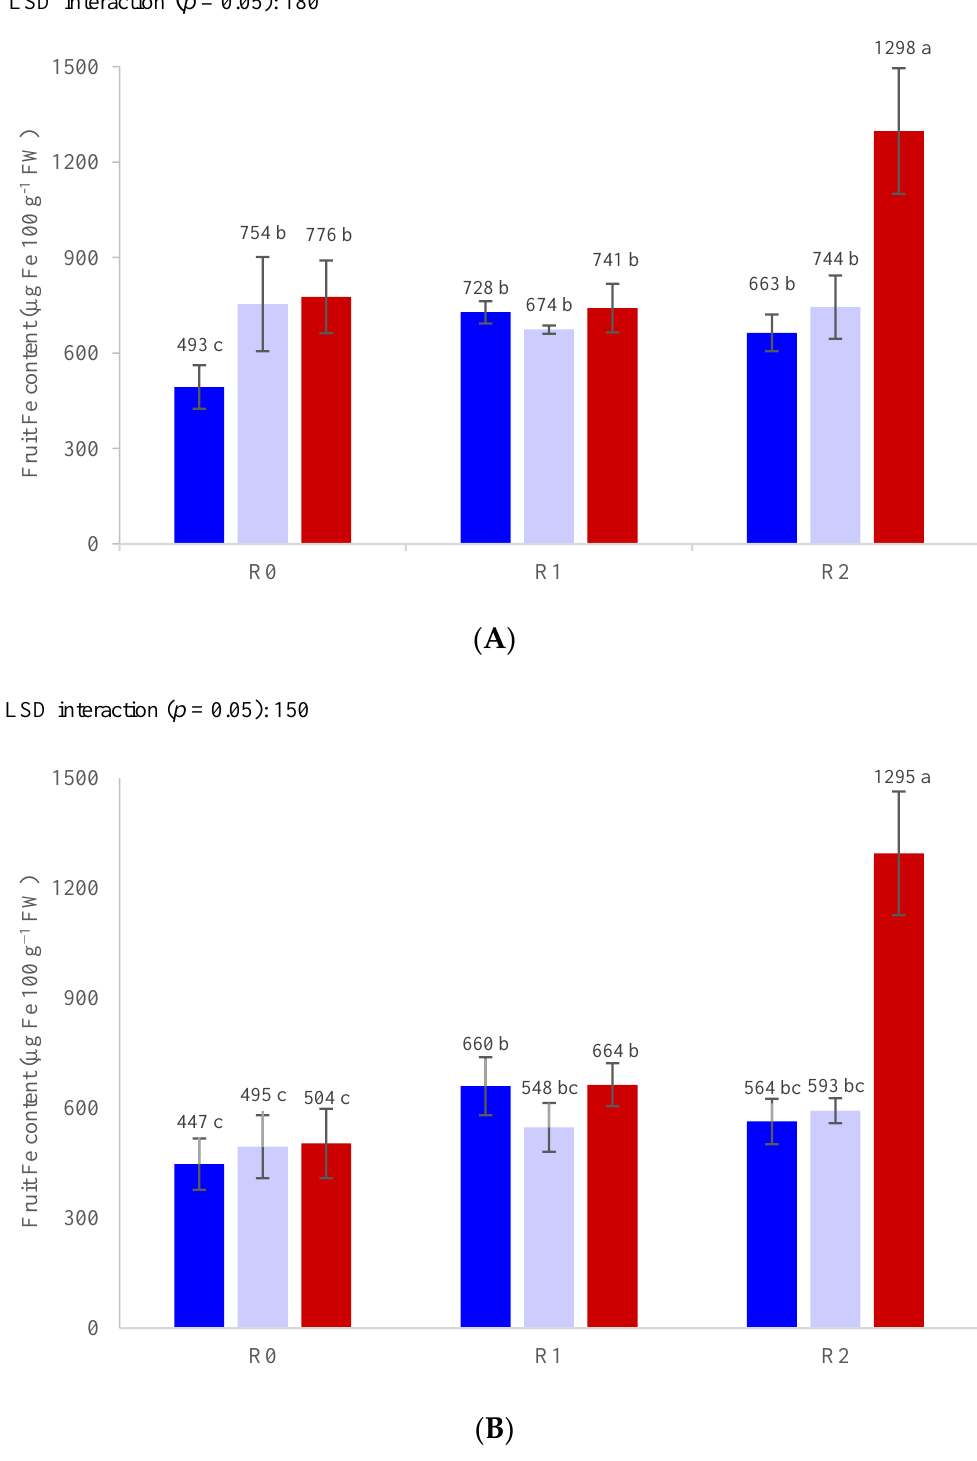
Figure 2. Iron content of cherry tomato fruits belonging to the ( A ) 1st and ( B ) 2nd clusters, as affected by the application of Fe. Blue bars: L0; lilac bars: L250; red bars: L500. Different letters indicate significance according to Fisher’s protected LSD test ( p = 0.05). Error bars indicate the standard deviation.